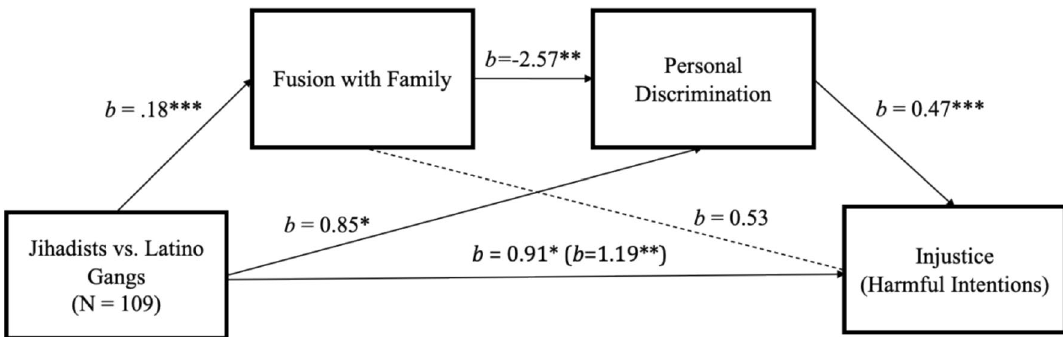
Figure 5. Mediation analyses showing: (1) jihadists express more fusion with family and personal discrimination than do gang members; (2) fusion with family reduces the perception of personal discrimination, which in turn is associated with less perceived injustice in sentencing. b values are unstandardized β values; * p < .05; ** p < .01; *** p < .001. Total effect: b = 1.19, 95% CI [0.36, 2.02]. Direct effect: b = 0.91, 95% CI [0.07, 1.75]. Indirect effects: Group > Fusion family > Injustice: b = 0.09, 95% CI [− 0.28, 0.52]; Group > Discrimination > Injustice: b = 0.40, 95% CI [0.003, 0.83]; Group >